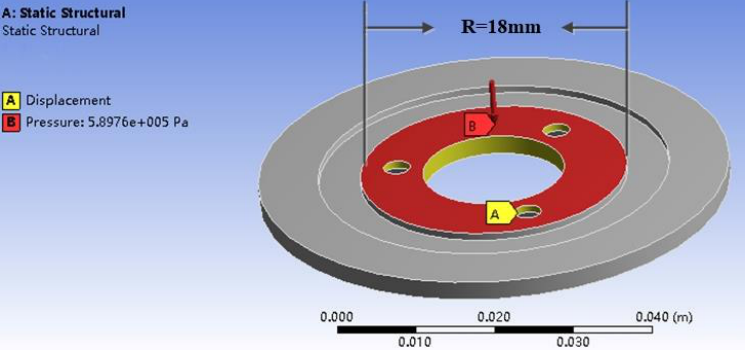
Figure 8. Schematic diagram of pre-pressure application.